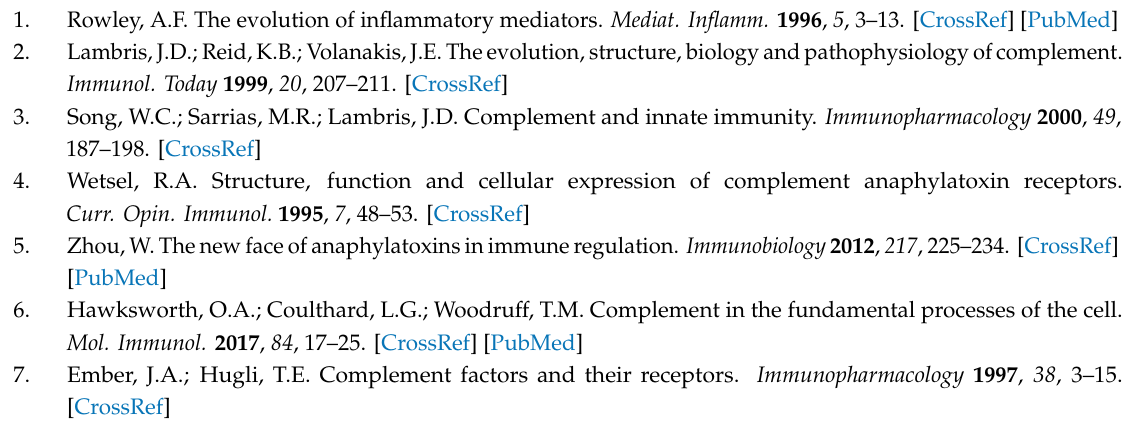
Figure S1. Genomic sequence of BsC3a / C5aR (g020950). Exon sequences are in grey and AG-GT splicing signal consensus sequences are marked in purple. Figure S2. Alignment of ascidian putative anaphylatoxin receptors and human C3aR. The seven TM domains are marked yellow; conserved residues are indicated with an asterisk on the bottom of the alignment; the Tyr and the Thr residues considered important for the binding to anaphylatoxin and receptor internalization, respectively, are marked green and light blue. TM: